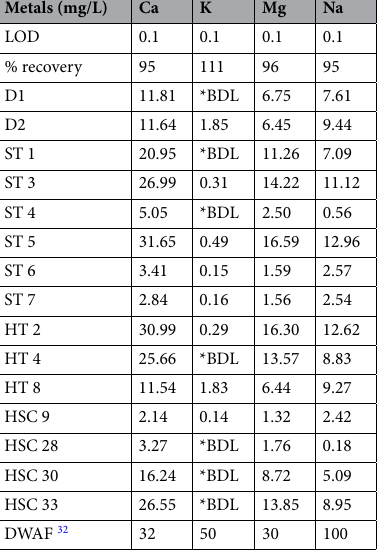
Table 7. Cations indicators in water. LOD- Limit of detection; *BDL -below detection limit.